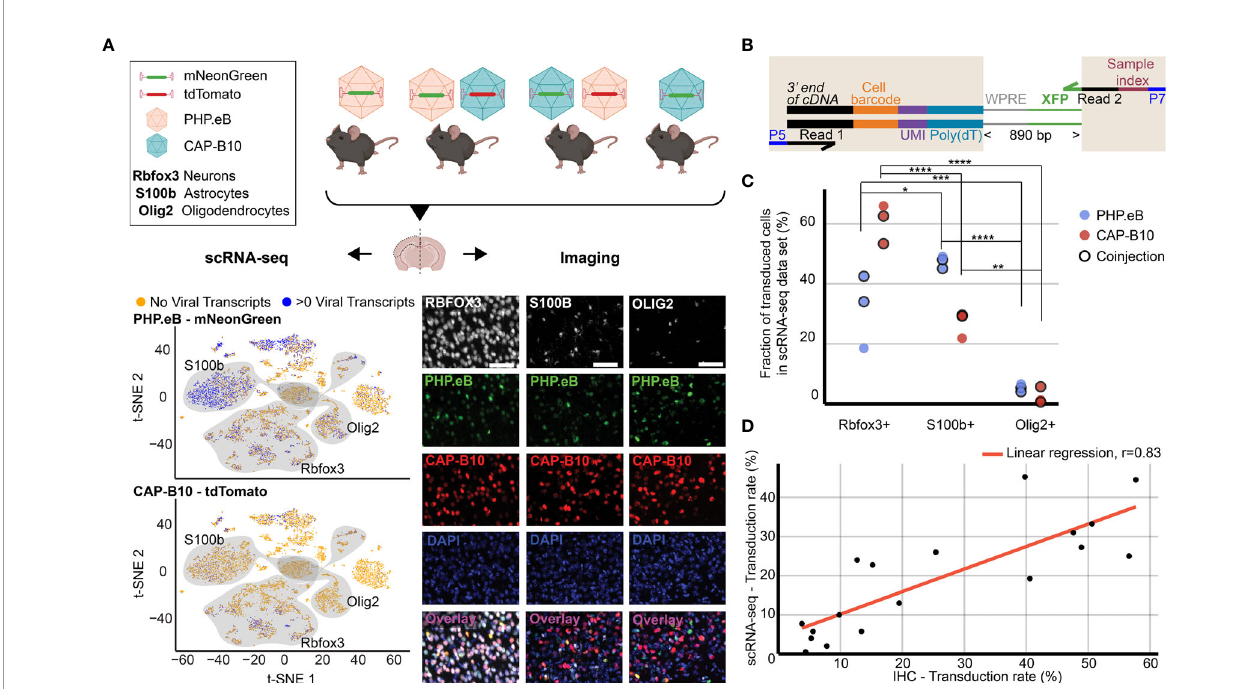
FIGURE 2 | Comparison of viral tropism pro fi ling with traditional IHC and scRNA-seq. (A) Overview of the experiment. Four animals were injected with 1.5 ×10 11 viral genomes (vg) packaged in AAV-PHP.eB and/or AAV.CAP-B10. The bottom panels show a representative dataset collected from an animal that was co-injected with AAV-PHP.eB and AAV.CAP-B10. The left side displays the scRNA-seq dataset in the lower dimensional t-SNE space, with cells colored according to presence of viral transcripts. The shaded areas indicate clusters with high expression of the corresponding gene marker. The right side shows representative confocal images of cortical tissue labeled with IHC. Scale bar, 50 µm. (B) Viral transcript recovery strategy. The shaded areas highlight sequences added during library construction. (C) The fraction of the total number of transduced cells labeled as expressing the corresponding marker gene. For each AAV variant, the results of a two-way ANOVA with correction for multiple comparisons using Sidak ’ s test are reported with adjusted P-values (****P ≤ 0.0001, ***P ≤ 0.001, and **P ≤ 0.01, and *P ≤ 0.05 are shown; P > 0.05 is not shown). (D) Comparison of transduction rates based on quanti fi cation via scRNA-seq or IHC. Transduction rate in IHC was calculated as (number of transduced cells in the group)/(total number of cells in the group). Transduction rate in scRNA-seq is based on an estimate of the fraaction of cells containing transcripts above background (see Methods ). Each dot represents the transduction rate of neurons/Rbfox3+, astrocytes/S100b+, or oligodendrocytes/Olig2+ by AAV-PHP.eB or AAV.CAP-B10 in one animal. Histology data are averages across three brain slices per gene marker and animal. r indicates the Pearson correlation coef fi